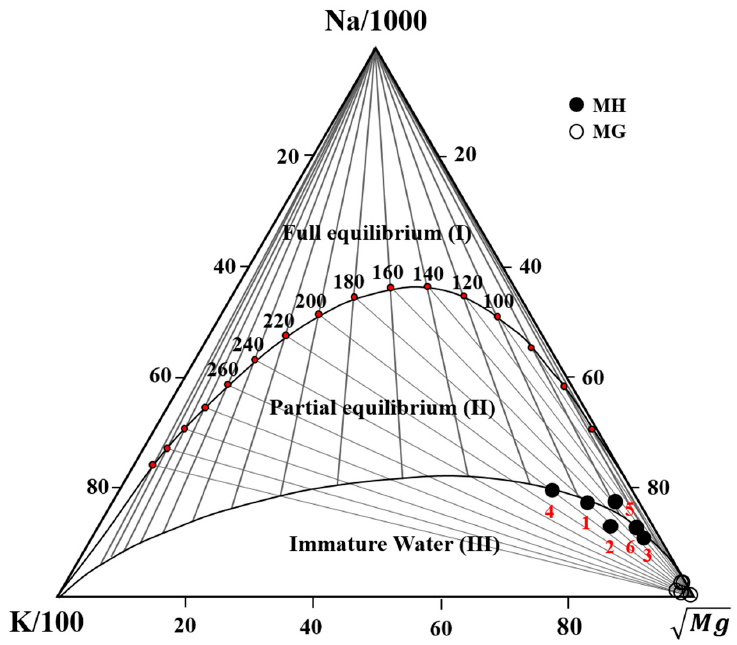
Figure 12. Ternary Na–K–Mg plot of thermal waters (filled circles with number) and groundwaters (open circles), showing water–rock equilibrium temperatures [11].